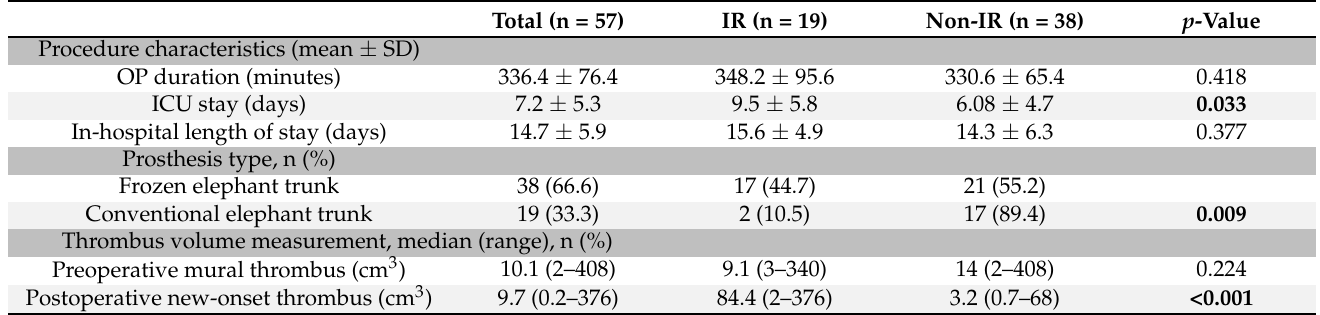
Table 2. Procedural and perioperative data of the study population overall and in the subgroup distributed according to the presence of